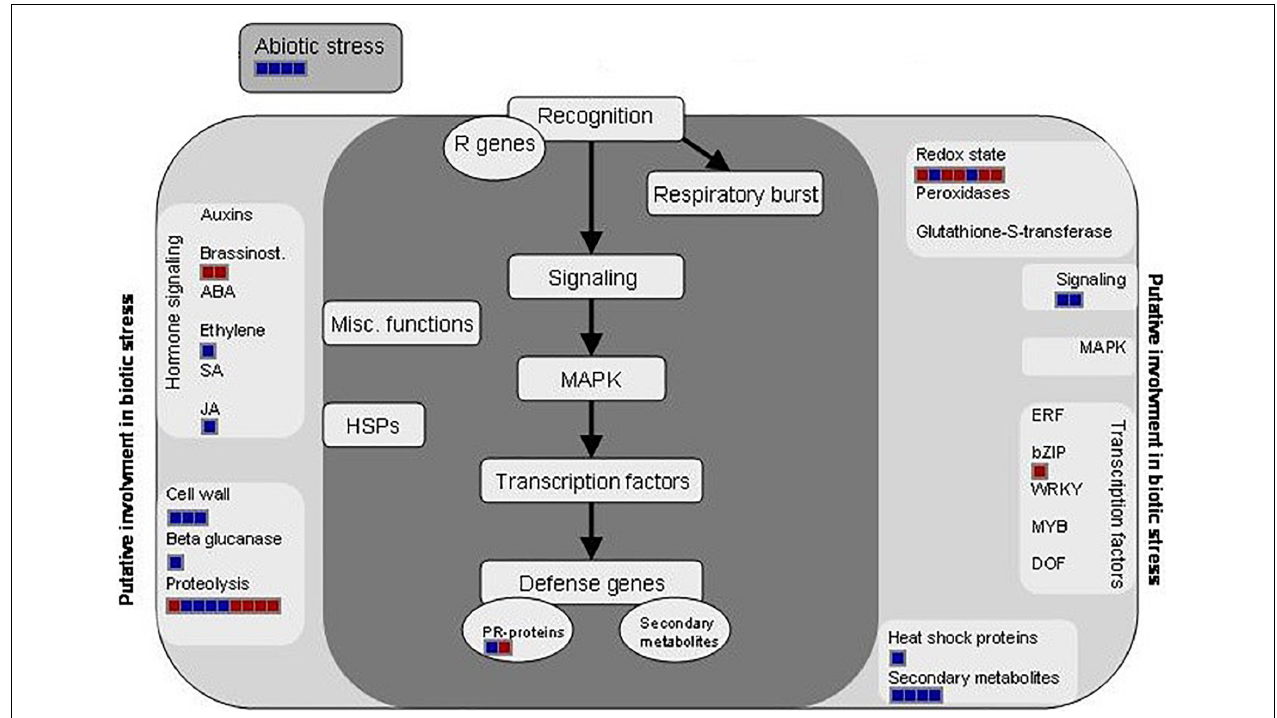
FIGURE 3 | Distribution of the differentially regulated proteins at 12 dpi and involved in biotic stress processes (hormone signaling, secondary metabolism activation, and redox homeostasis) by using the MapMan software and after the infection of Brassica oleracea leaves by Xanthomonas campestris pv. campestris . Red square: downregulated protein; blue square: upregulated